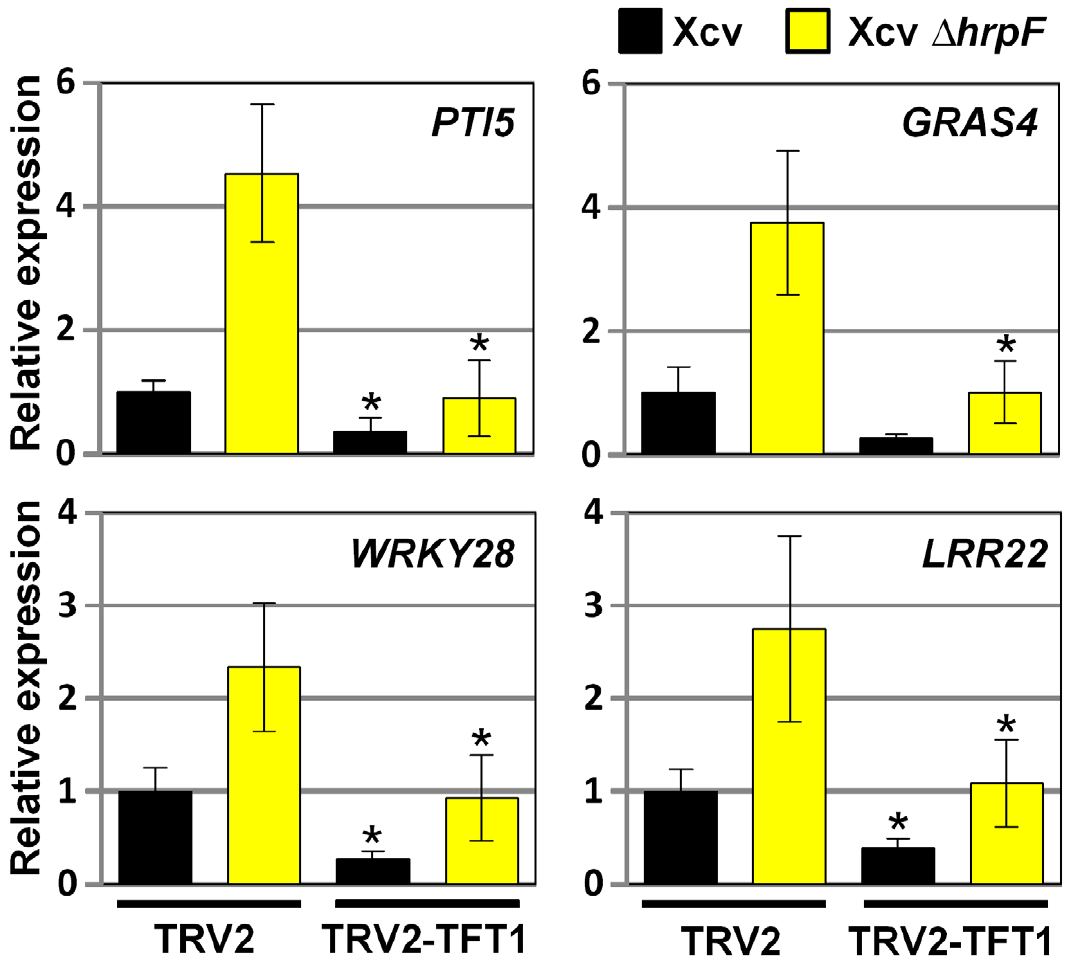
Figure 3. Reduced TFT1 mRNA expression in VIGS tomato leaves correlates with reduced PTI marker mRNA abundance in response to Xcv infection. Relative mRNA levels for four PTI marker genes ( PTI5 , GRAS4 , WRKY28 , and LRR22 ) in 4 control (TRV2) and 4 TFT1 -silenced (TRV2- TFT1) tomato lines. Leaflets on the same branch were inoculated with 1 6 10 5 CFU/mL of Xcv or Xcv D hrpF . Total RNA isolated from inoculated leaves at 6 HPI was used for Q-PCR. Actin mRNA expression was used to normalize the expression value in each sample. Error bars indicate SD for four plants. Asterisk indicates significant difference ( t test, P , 0.05) in the infected TRV2-TFT1 lines compared to the similarly infected TRV2 lines.